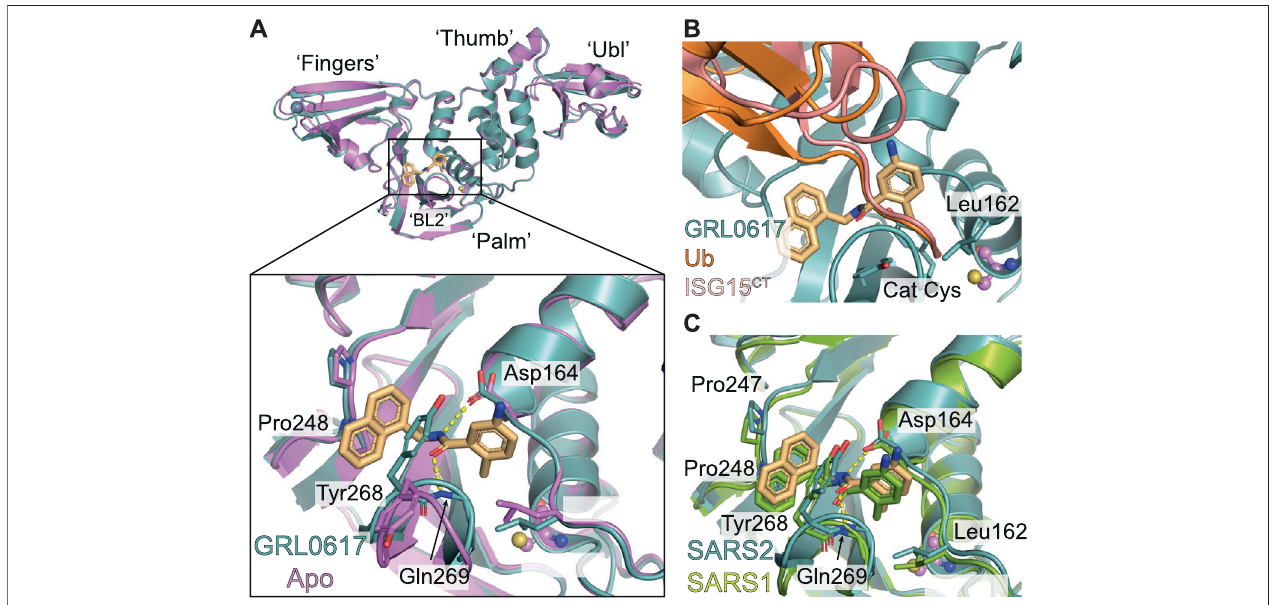
FIGURE 2 | Molecular basis for inhibition of SARS-CoV-2 PLpro by GRL-0617 . (A) Structure of SARS-CoV-2 PLpro bound to GRL-0617 in teal (PDB 7JRN (Ma et al., 2021)), with inhibitor in wheat colour in ball-and stick representation representing the (R)-enantiomer. A close-up view of the ligand binding site for GRL-0617 with key residues indicated is also shown and hydrogen bonds are displayed as a dashed yellow line. A superimposed structure of apo PLpro [purple, PDB 6WZU (Osipiuk et al., 2021)] shows that the inhibitor does not induce global conformational changes. The catalytic Cys is shown in ball and stick representation, and a bound zinc ion inapo PLpro isshown asagrey sphere. (B) Close-up view ofthe GRL-0617 binding site overlaid with ubiquitin from theubiquitin-PLpro complexin orange [PLpro ~ Ub, PDB 6XAA (Klemm et al., 2020)]and withISG15 from PLpro bound tothe C-terminalISG15 Ubl fold in pink[PLpro ~ISG15 CT ,PDB 6XA9 (Klemm et al., 2020)]. The orthomethyl resides in a pocket formed by Leu162, Tyr264, and Tyr273 occupying the position of the Arg74 in Ub or Arg155 in ISG15. Upon ligand binding, Leu162 rotatesits sidechaintoblockthechannel andthe pathoftheUbl tailtothecatalytic Cys111. Thecatalytic Cys111isshown inballand stickrepresentation. (C) Closeup view of the ligand binding site for GRL-0617 in SARS-CoV-2 PLpro in teal overlaid with SARS-CoV PLpro in green [PDB 3E9S (Ratia et al., 2008)]. Key residues are fully conserved between SARS-CoV and SARS-CoV-2 which explains cross speci fi city of compounds. Hydrogen bonds are displayed as a dashed yellow line.